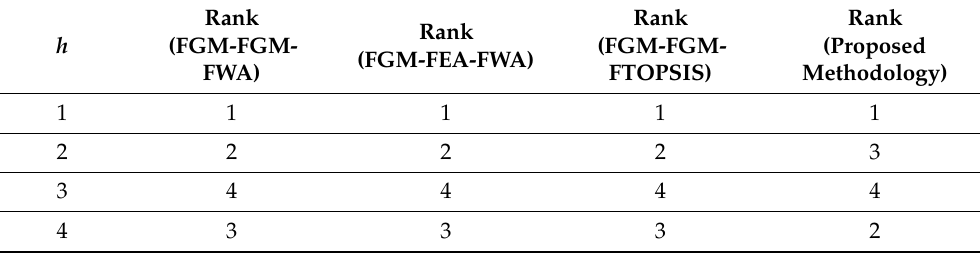
Table 11. Ranking results using existing methods.